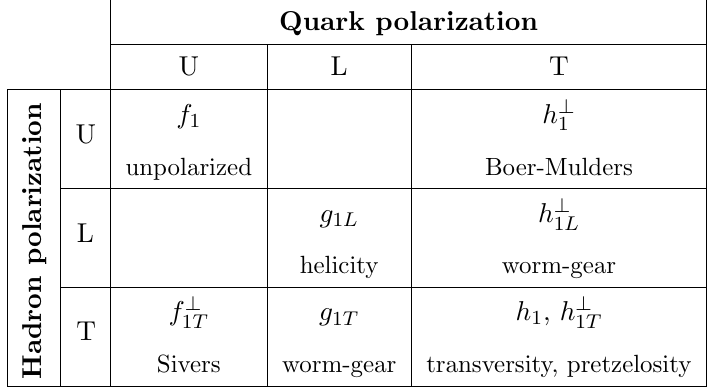
Table 1. Overview of the quark TMDs of a spin- 1 hadron at leading power in eq. (2.9), organized 2 by the polarization of the struck quark and the parent hadron. Here U, L, T stand for unpolarized, longitudinally polarized and transversely polarized, respectively. The Boer-Mulders and Sivers functions are time-reversal odd, while all other functions are time-reversal